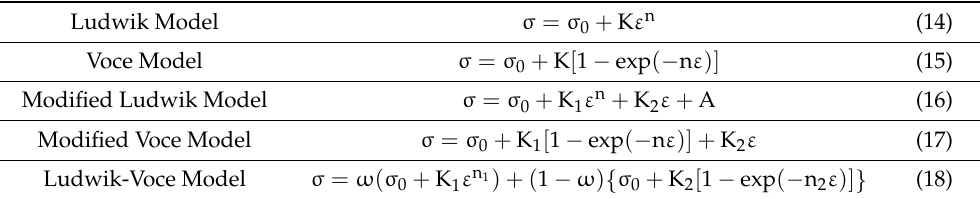
Table 3. Equations of strain models.